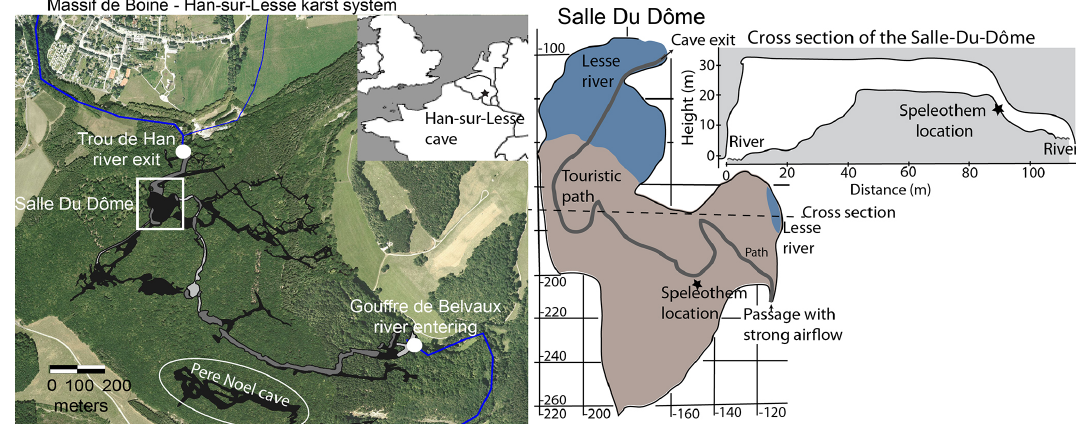
Figure 1. The Han-sur-Lesse karst system, with the Han-sur-Lesse cave as the northern cave system and the Père Noël cave (Verheyden et al., 2008a) as the southern cave system. The Lesse river enters the cave system at the “Gouffre de Belvaux” and exits 24h later at the “Trou de Han”. The studied speleothem is located in the “Salle-du-Dôme” and grows on a pile of debris. Figure adapted after Quinif